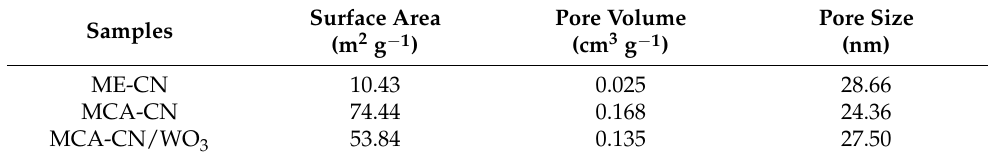
Table 1. Surface area, pore volume and pore size of ME-CN, MCA-CN and MCA-CN/WO 3